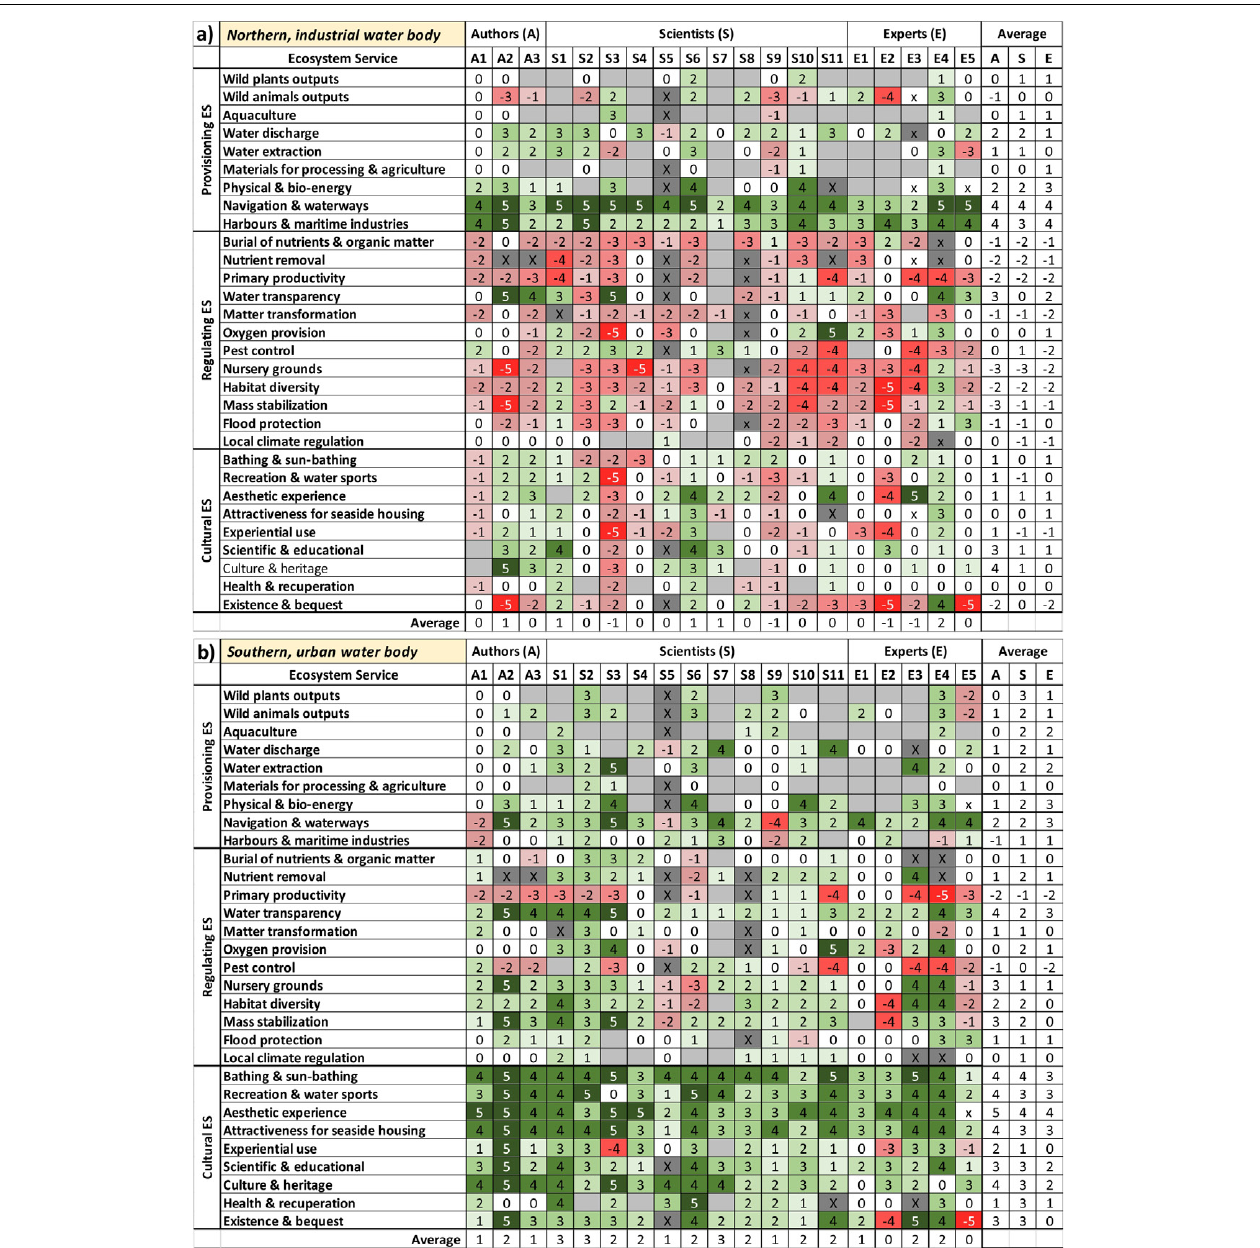
FIGURE 8 | Ecosystem service (ES) classes used in expert-based assessment for the Warnow Estuary. The authors, 11 scientists and 5 experts (persons working at water authorities on the WFD implementation) scored the changes between today and the future scenario “Warnow 2040.” The assessment is separated into two water bodies, the northern industrial (see a ) and the southern, urban (see b ) part of the estuary. Positive scores indicate that an increase in ES provision in future was assumed ( Figure 3 ). Gray cells indicate that the expert assumed the ES as not relevant. Gray cells with x indicate a lacking